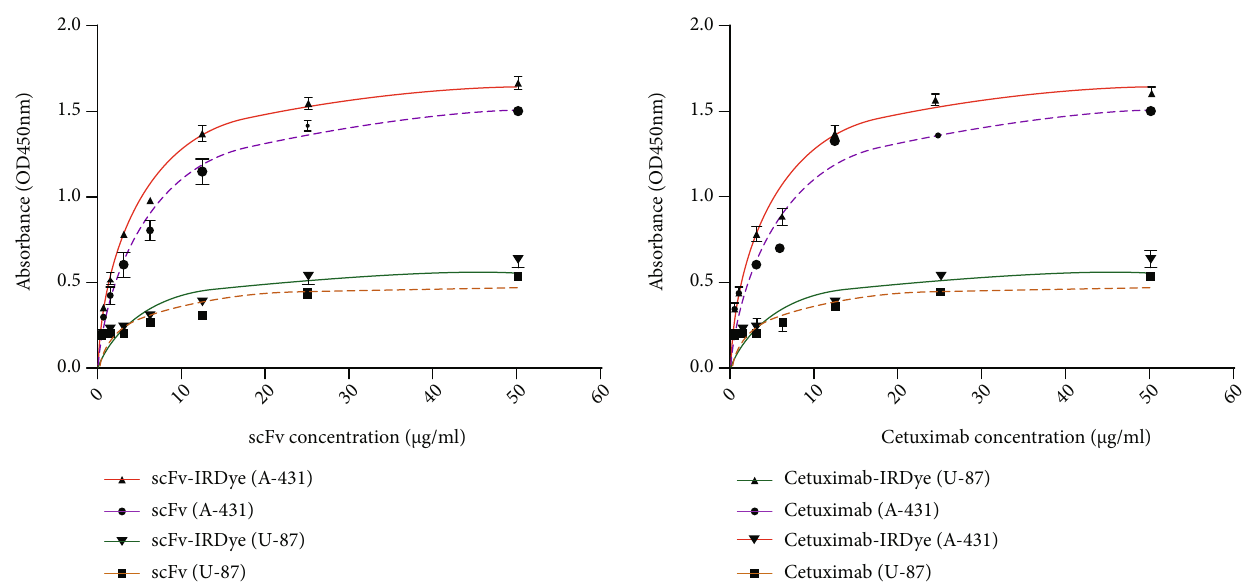
Figure 3: The saturation binding curves of IRDye800CW-labeled and unlabeled antibodies when reacting with A-431 and U-87 cells. All experiments were done in